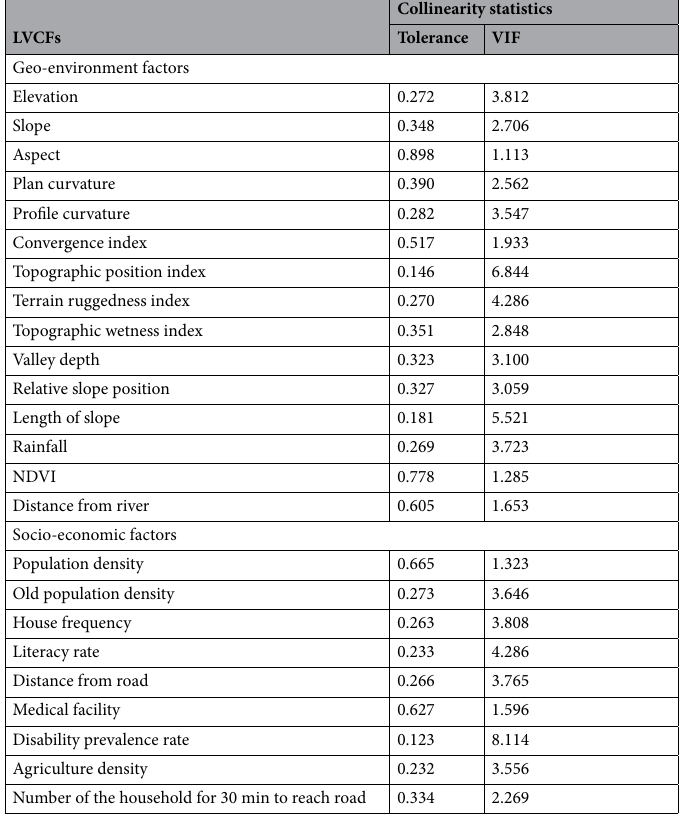
Table 2. Collinearity results of